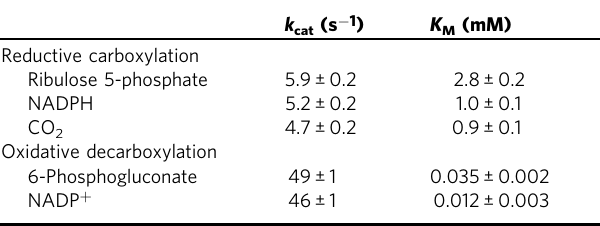
Values indicate mean ± standard error. Fitted Michaelis – Menten curves are shown in Supplementary Fig. 1. See the “ Methods ” section for a detailed description of the kinetic characterization.